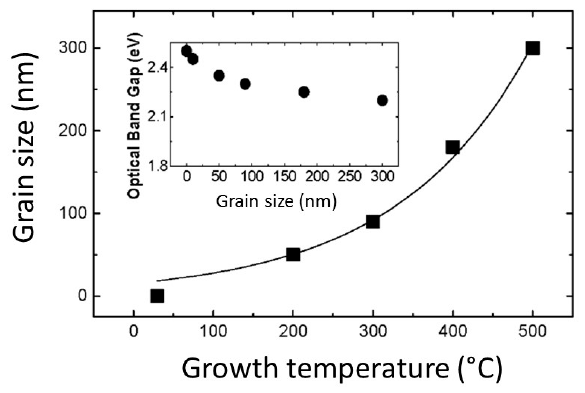
Figure 11. Variation of the grain size in V 2 O 5 thin films as a function of the substrate temperature. (Reproduced with permission from [205]. Copyright 2005 American Chemical Society).